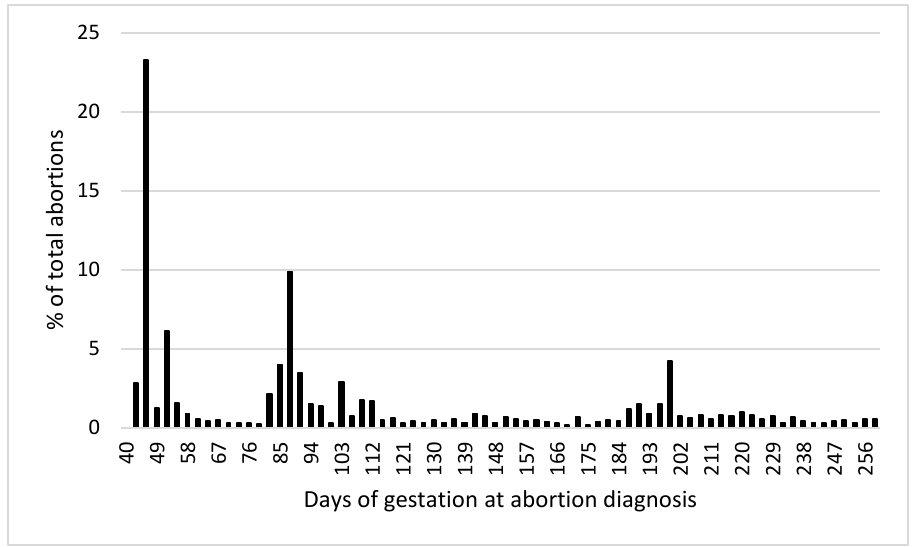
Figure 2. Distribution of abortion incidence by days of gestation at the time of abortion diagnosis.